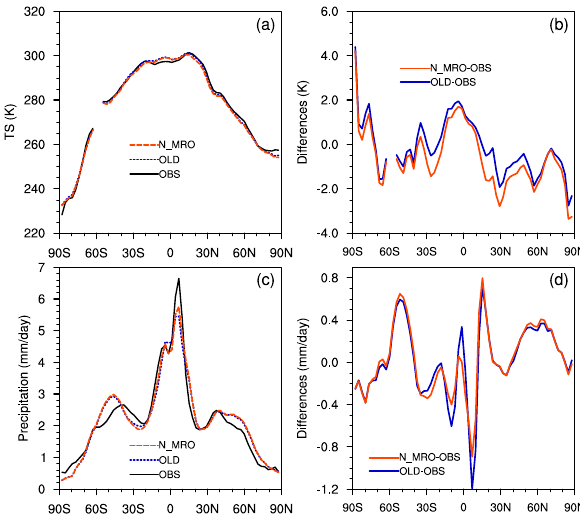
Fig. 5. Zonal annual mean (a) surface temperature and (c) precipi- tation from N_MRO, OLD, and observation data, as well as (b, d) the differences between N_MRO and observations (red solid lines) and between OLD and observations (blue solid lines). The observa- tion data for temperature are from the ERA-Interim reanalysis, and those for precipitation are from the Xie and Arkin (1997) data